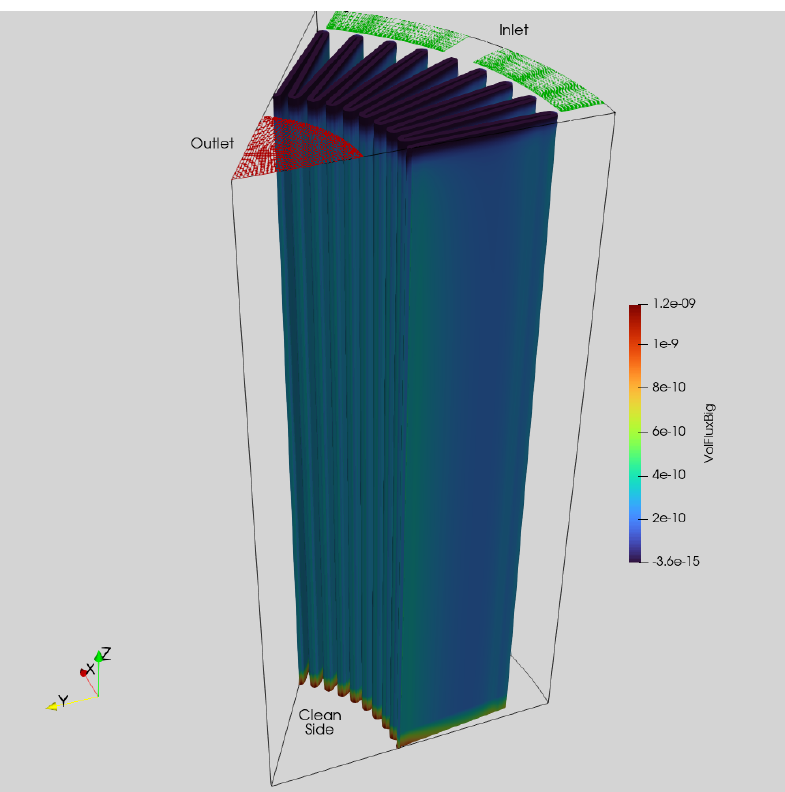
Figure 7. Flux of particle mass for particles with diameters in the upper range of the distribution ( ≥ 70 µ